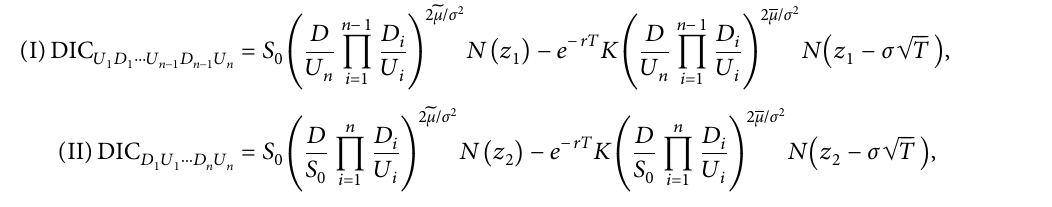
Figure 2: Comparison of UIC , UIDIC , DIC